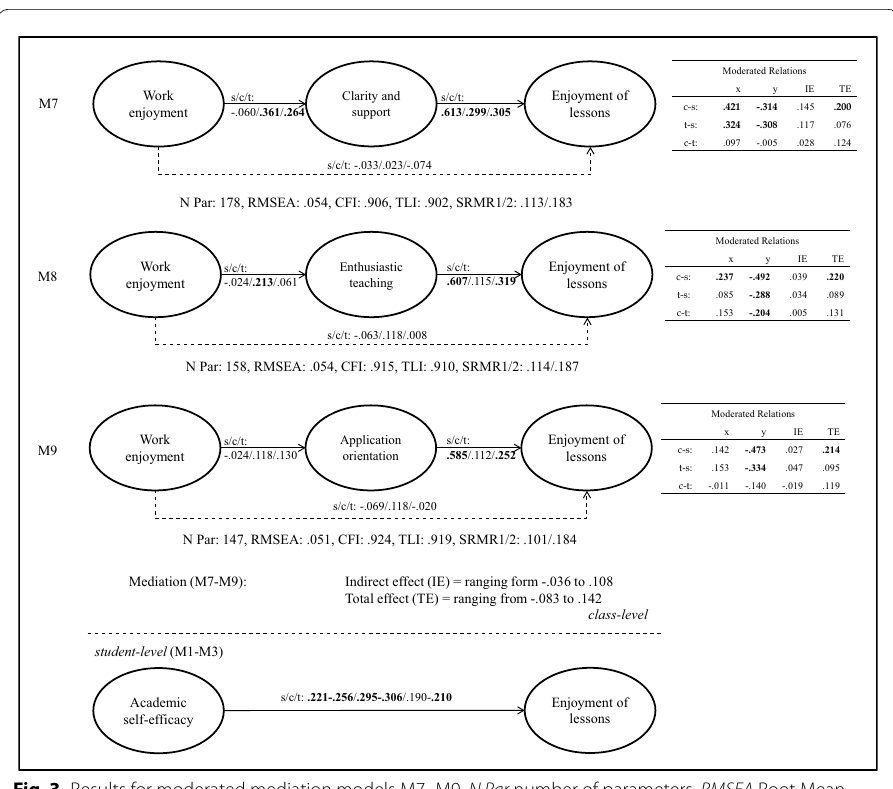
Fig. 3 Results for moderated mediation models M7–M9. N Par number of parameters, RMSEA Root Mean Square Error of Approximation, CFI Comparative Fit Index, TLI Tucker Lewis Index, SRMR Standardized Root Mean Square Residual, SRMR1 SRMR within, SRMR2 SRMR between, s social domain, c commercial domain, t technical domain, x path from work enjoyment to teaching characteristic, y path from teaching